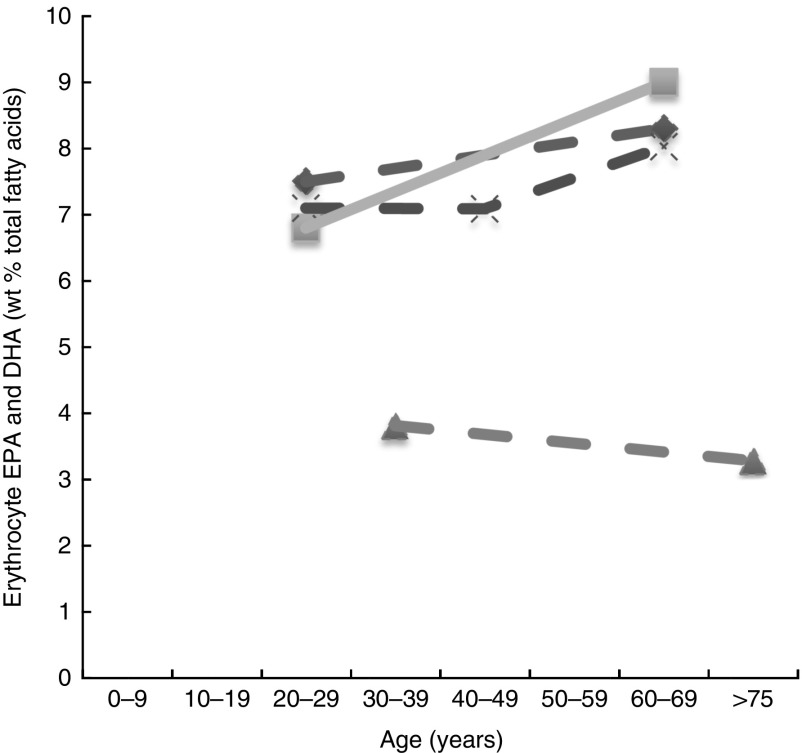
Erythrocyte EPA levels and DHA (wt% of total fatty acids) of different age groups from studies reviewed in this systematic literature review. Each line represents a different study (population) and each symbol on a line represents an age group. Full line=significant difference between age groups measured in that study. Broken line=no significant difference between age groups measured in that study. , Kawabata et al.
(

53

) (women subjects) NS; , Kawabata et al.
(

53

) (male subjects); , Babin et al.
(

57

) NS; , Walker et al.
(

39

) NS.